Question: Write a descriptive caption for this figure.
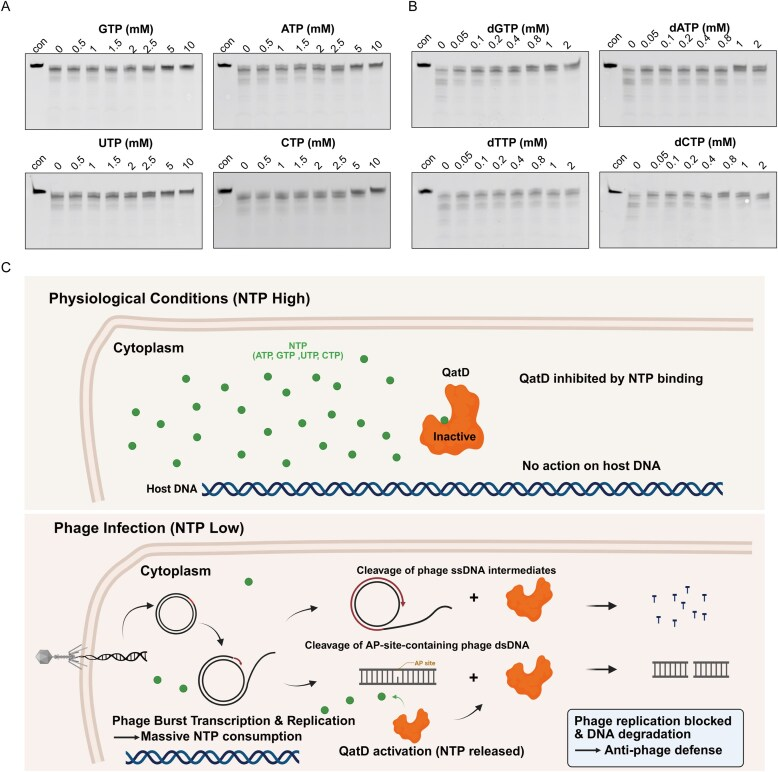
Answer: QatD exonuclease activity is inhibited by NTPs but not dNTPs. ( A ) The exonuclease activity of QatD was assayed using a 5′-FAM-labeled ssDNA substrate. Reactions containing 0.5 μM QatD and 0.1 μM substrate in the presence of 10 mM Mg 2+ were incubated at 37°C for 20 min, supplemented with the indicated concentrations of each NTPs (0–10 mM). Each assay was conducted in triplicate. ( B ) The exonuclease activity of QatD was assayed using a 5′-FAM-labeled ssDNA substrate. Reactions containing 0.5 μM QatD and 0.1 μM substrate in the presence of 10 mM Mg 2+ were incubated at 37°C for 30 min, supplemented with the indicated concentrations of each dNTPs (0–2 mM). All assays were performed in three independent replicates. ( C ) Model of NTP–dependent regulation of QatD anti–phage activity. High cellular NTP keep QatD inactive; phage–induced NTP depletion activates QatD to degrade phage DNA and inhibit phage propagation.